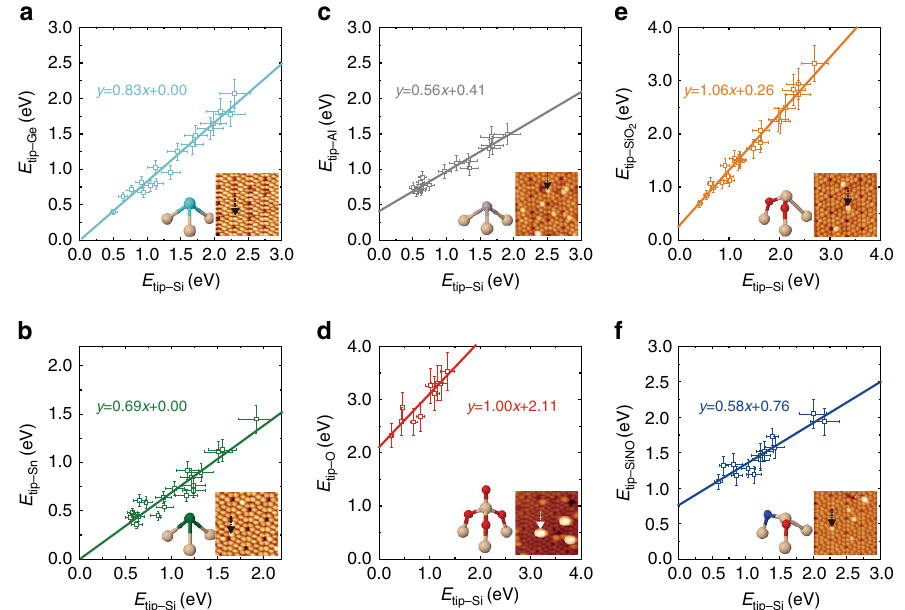
Figure 2 | Linear relations between bond energies of different chemical species. Scatter plots of the bond energies of Ge ( a ), Sn ( b ), Al ( c ), O ( d ) adatoms, SiO 2 ( e ) and SiNO ( f ) complexes obtained experimentally. The bond energies were measured above the bright spots in AFM images as shown in the insets. The individual error bars are estimated as 10% of the corresponding bond energies based on uncertainties in measurements of A and k . The scatter plots were fitted using weighted orthogonal distance regression.